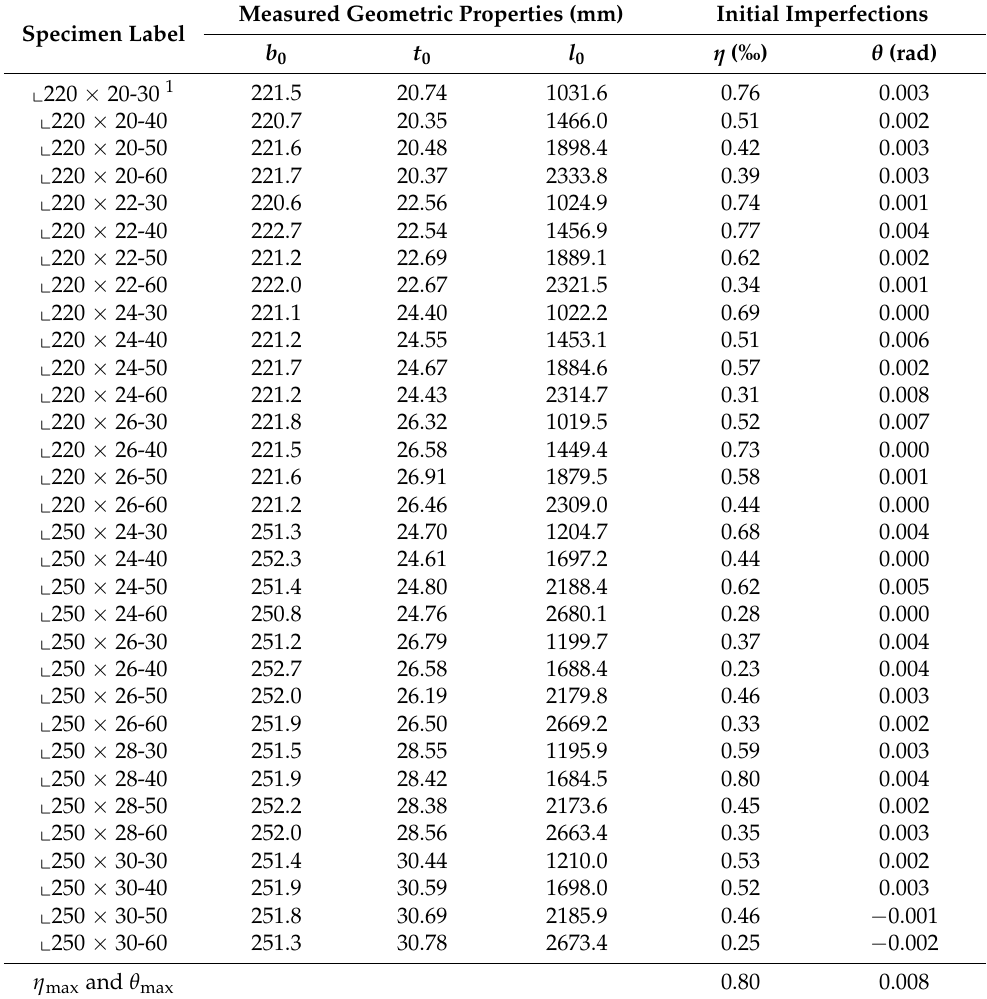
Table 2. The measured geometric properties and initial